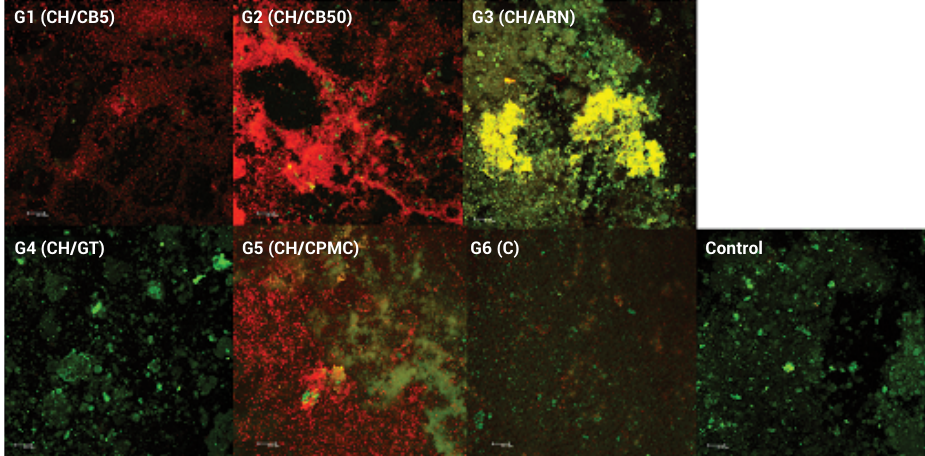
Figure 1. Confocal laser scanning microscopy of biofilms treated with benzalkonium chloride 5% (G1) and 50% (G2), arnica glycolic extract (G3), green tea glycolic extract (G4), camphorated paramonochlorophenol (CMCP) (G5), and Calen (G6) (control). Live cells are indicated in green, and dead cells are indicated in red. Each picture represents an area of 275 X 275